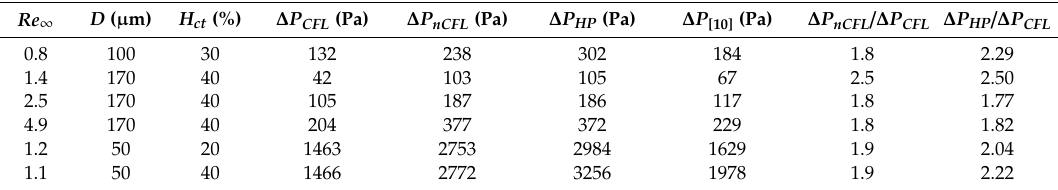
Table 5. Pressure drop for various